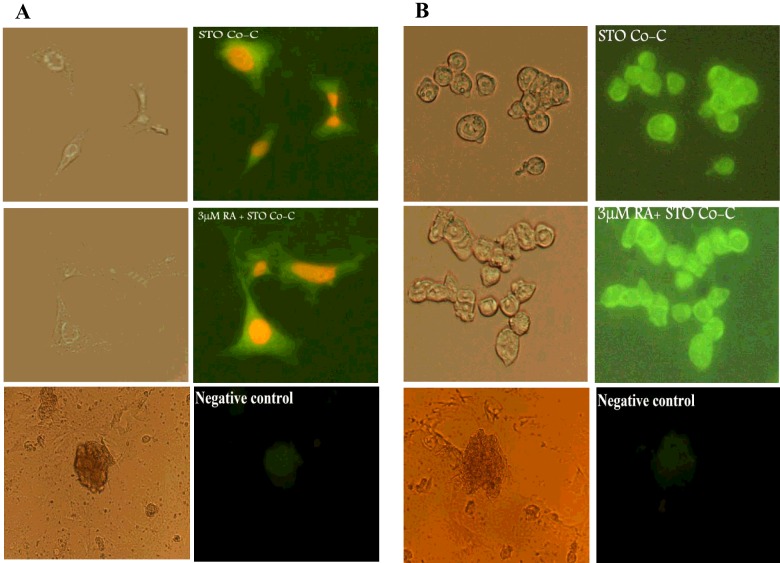
Cytochemistry of Mvh and CDH1Positive immunostaining and negative controls for (A) Mvh marker characterizing the transdifferentiated PGCs (counterstained with ethidium bromide) and for (B) CDH1 marker used for characterizing the late germ cell differentiation. The cells immunostained with anti-Mvh and anti-CDH1 (arrow) antibodies that reacted with FITC-conjugated secondary antibodies in the STO Co-C and 3 μM RA concentrations+STO Co-C groups (×200) after 4 days induction with BMP4 followed by 7 days exposure with RA. The right panels show the phase contrast of the positive immunostained cells and negative control.